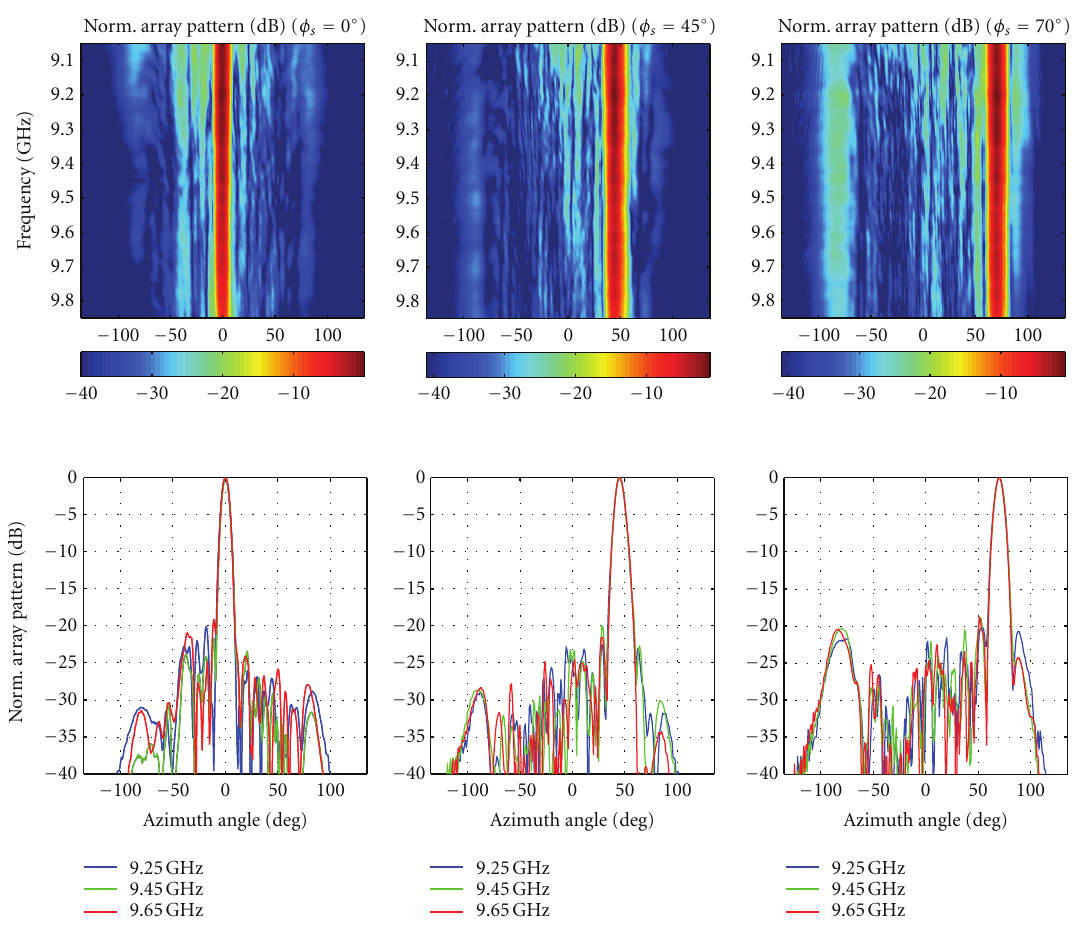
Figure 8: Measured array radiation pattern at scanning angles (0 ◦ , 45 ◦ , and 70 ◦ ) in RX operation and its variation over frequency.